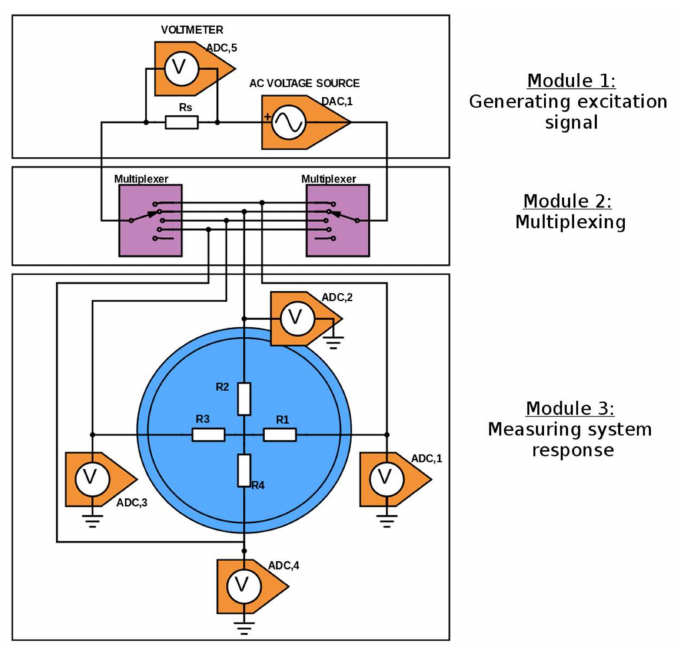
Figure 1. Sketch of the setup for the classical tomography experiment. An AC voltage source generates the excitation signal. Multiplexers route the signal to the target electrodes. Voltmeters measure the system response (voltages). In the blue disk, four resistances represent the mock-up of a test section with the ROI.